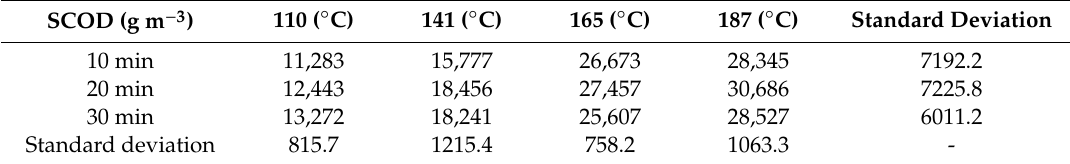
Table 7. Standard deviation of temperature and time during thermal